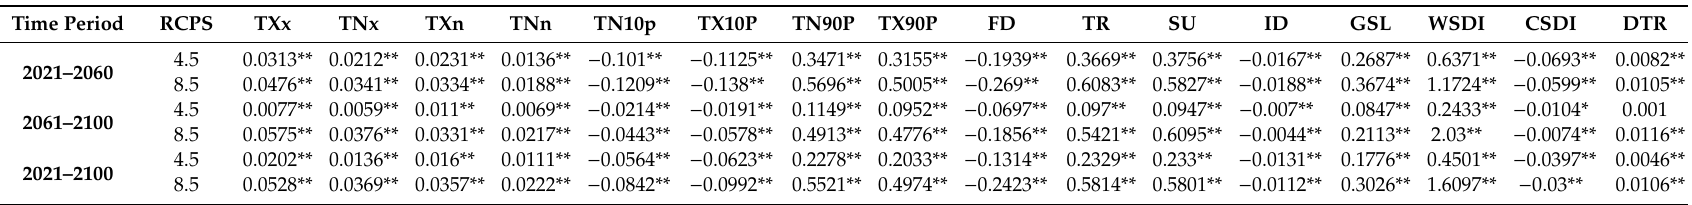
Table 4. Trends of the multi-model arithmetic mean for the 16 temperature indices during 2021–2100 under the two scenarios. * p < 0.05, ** p < 0.01. Time